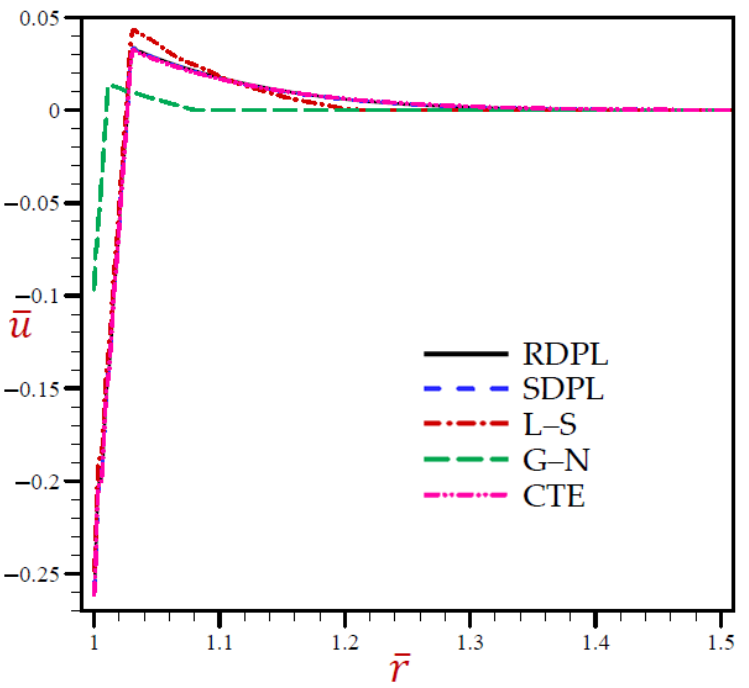
Figure 4. The radial displacement u through radial direction of spherical hole presenting to all models.